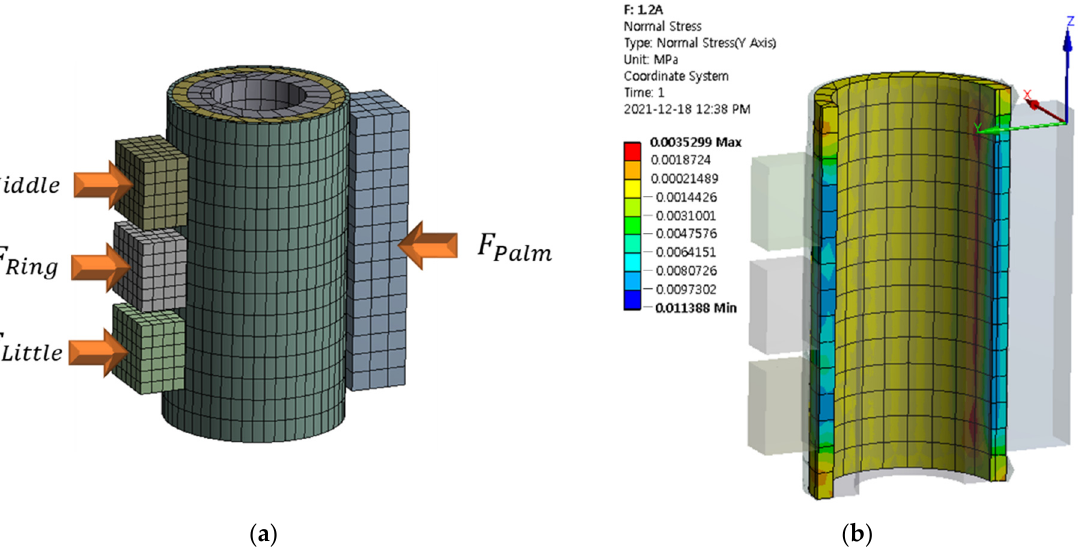
Figure 10. The finite element model of MRTGC with the handgrip: ( a ) 3D model of meshed MRTHC, ( b ) cross-section of normal force generated when hand deformation occurs in MRTGC section. Table 2. The simulated value of stiffness of MRTGC.